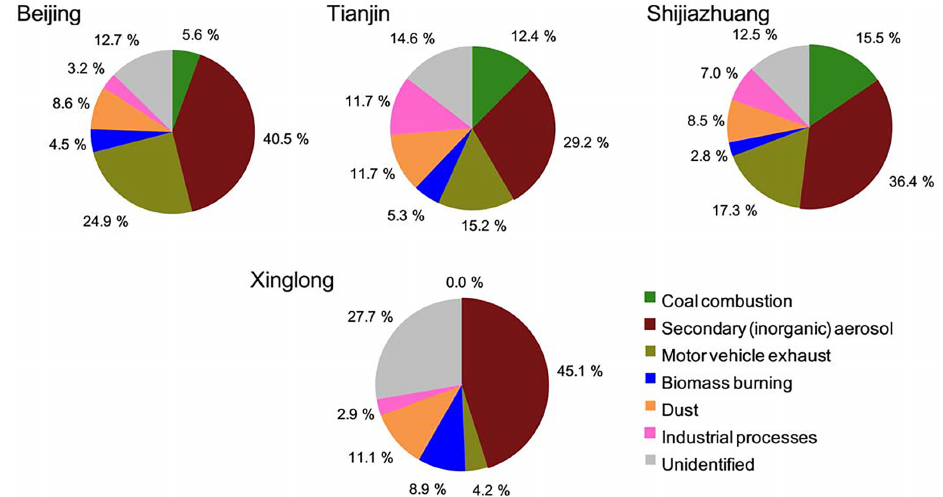
Figure 6. The annual contributions of the identified sources to PM 2 . 5 masses at the four